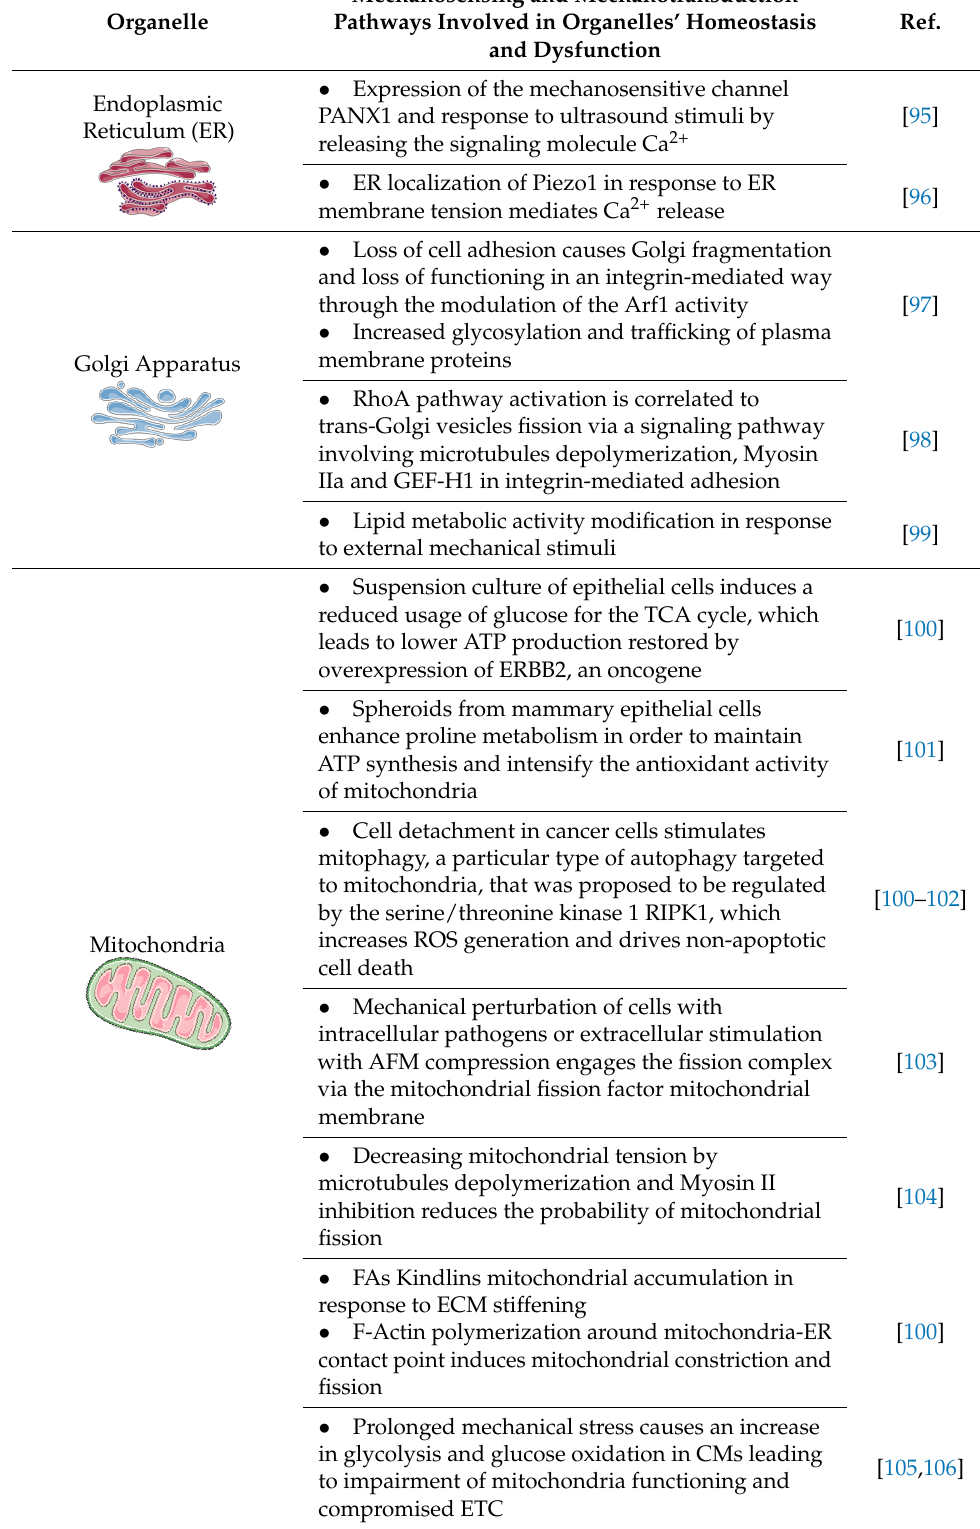
Table 1. Intracellular transmission of mechanosensing and mechanotransduction pathways: the involvement of organelles’ homeostasis and dysfunction.